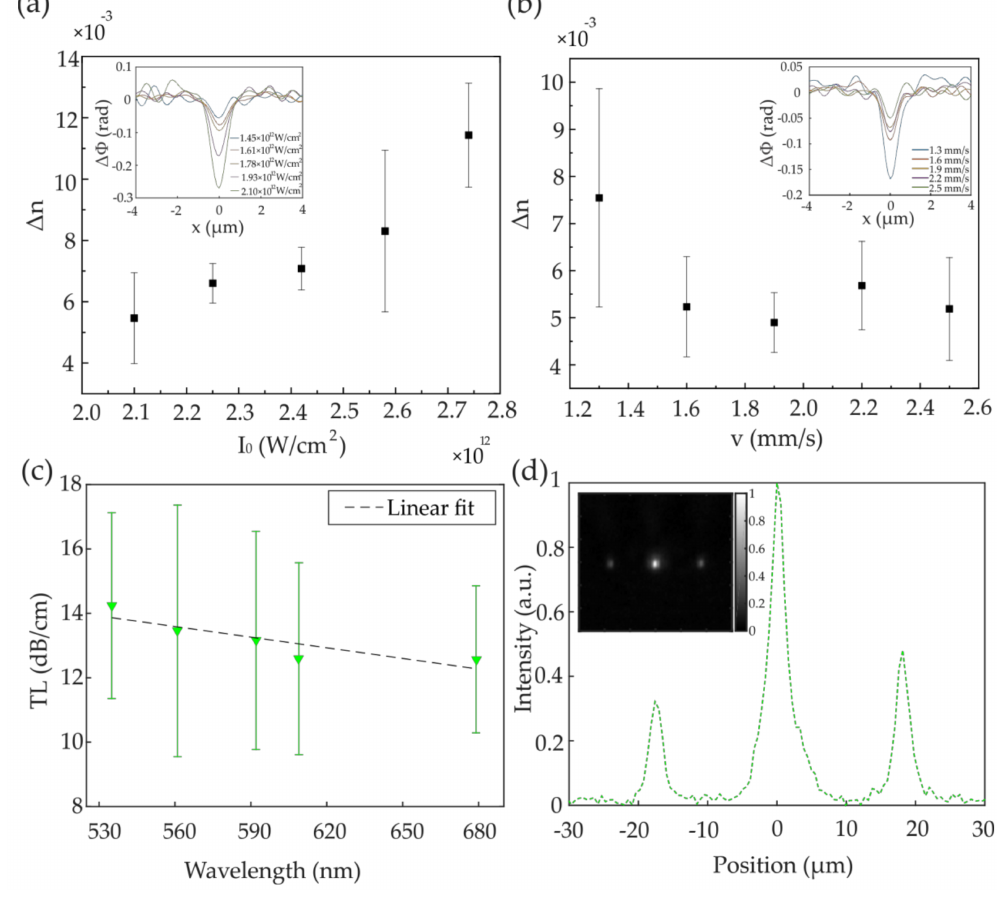
Figure 4. ( a ) Evolution of the refractive index as a function of increasing peak intensity (and constant writing speed v = 1.8 mm / s) is displayed. The laser peak intensity ranged between ~2.10 × 10 12 W / cm 2 and ~2.74 × 10 12 W / cm 2 ; ( b ) Refractive index contrast for waveguides recorded at ~2.25 × 10 12 W / cm 2 constant laser intensity and di ff erent writing speed, increasing from 1.3 to 2.5 mm / s. The insets display the measurement of the phase profile for di ff erent laser peak intensities and velocities, where each phase profile is the mean profile measured from three waveguides written with the same fabrication parameters; ( c ) Transmission loss in dB / cm as a function of wavelength, where colored filters have been inserted in the optical path to measure the output from three di ff erent simple waveguides written 500 µ m apart from each other; ( d ) Output intensity profile of three simple waveguides at an inter-waveguide distance of ~18 µ m; light in the 535 / 43 nm spectral band has been coupled in the central waveguide. Waveguide outputs are displayed in the image inset. Error bars indicate the standard deviation from three waveguides fabricated with the same experimental